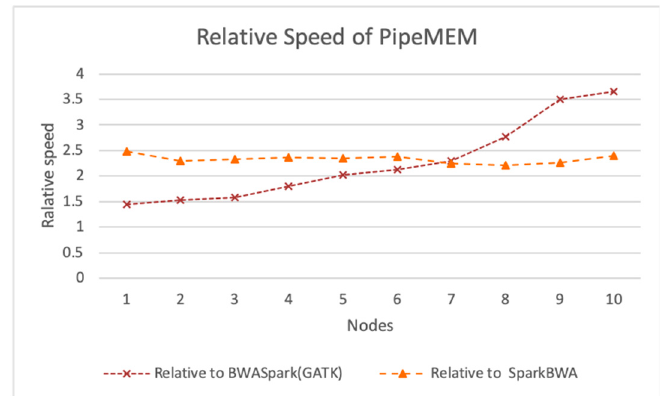
Figure 10. Relative speed of PipeMEM to BWASpark (GATK) and PipeMEM to SparkBWA. At every different node environment, PipeMEM maintains a higher performance compared with BWASpark and SparkBWA. PipeMEM is at least 2.2 times faster than SparkBWA and at least 1.5 times faster than BWASpark. The relative performance between PipeMEM and SparkBWA is relatively stable. The relative speedup of PipeMEM to SparkBWA is increasing as the number of nodes increases. It achieves about 2.66 × speedup at the 10-node environment. On average, PipeMEM is 2.33 times faster than SparkBWA and 2.27 times faster than BWASpark.